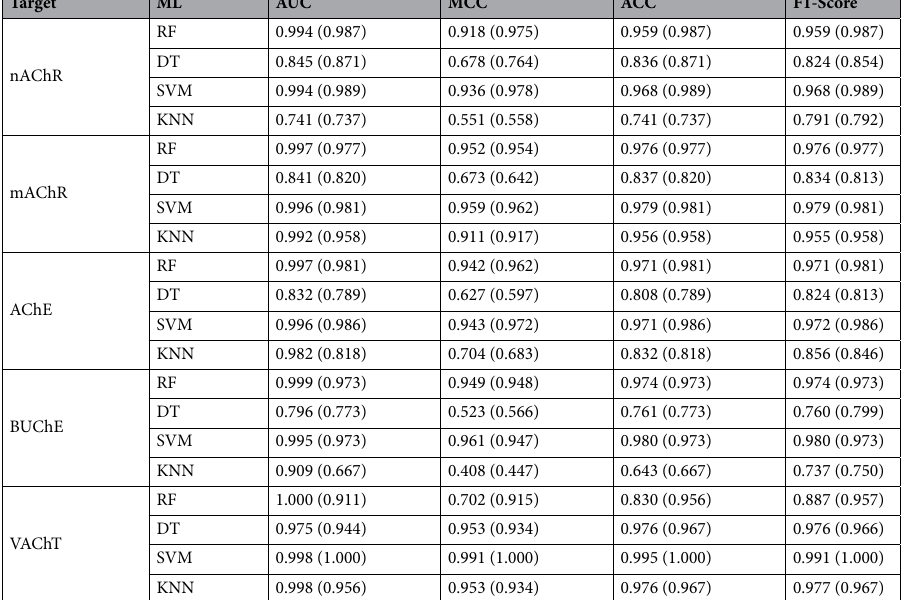
Table 1. The classification performance of selected best model based on ensemble-AUC for train and test set. ACC Accuracy, MCC Matthew’s Correlation Coefficient, RF Random Forest, DT Decision Tree, SVM Support Vector Machine, KNN K-Nearest Neighbor, nAChR Nicotinic Acetylcholinesterase Receptor, mAChR Muscarinic Acetylcholinesterase Receptor, AChE Acetylcholinesterase Enzyme, BuChE Butyrylcholinesterase Enzyme, VAChT Vesicular Acetylcholine Transporter. The values in parenthesis belong to the test set. The best model was selected based on the ensemble-AUC (Table